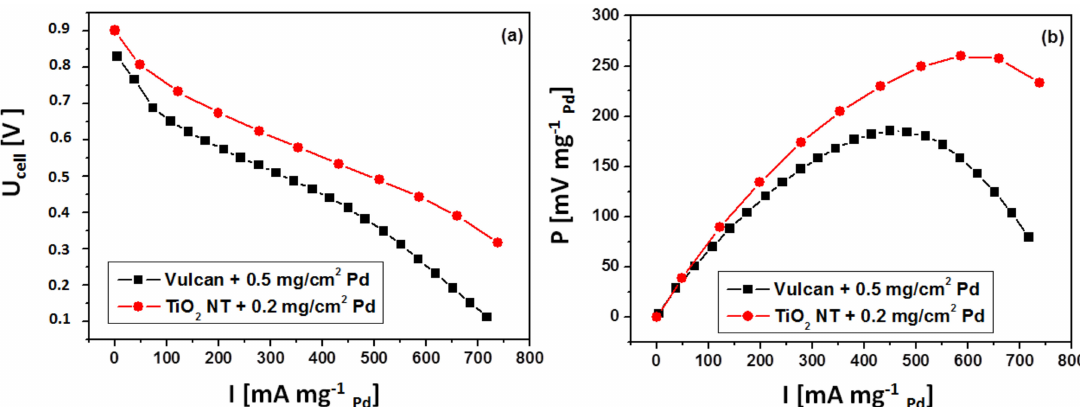
Figure 9. Comparison of the current–voltage curves ( a ) and power vs. specific current ( b ) for electrooxidation of 3 M HCOOH when using Pd / Vulcan or Pd / TiO 2 as anode